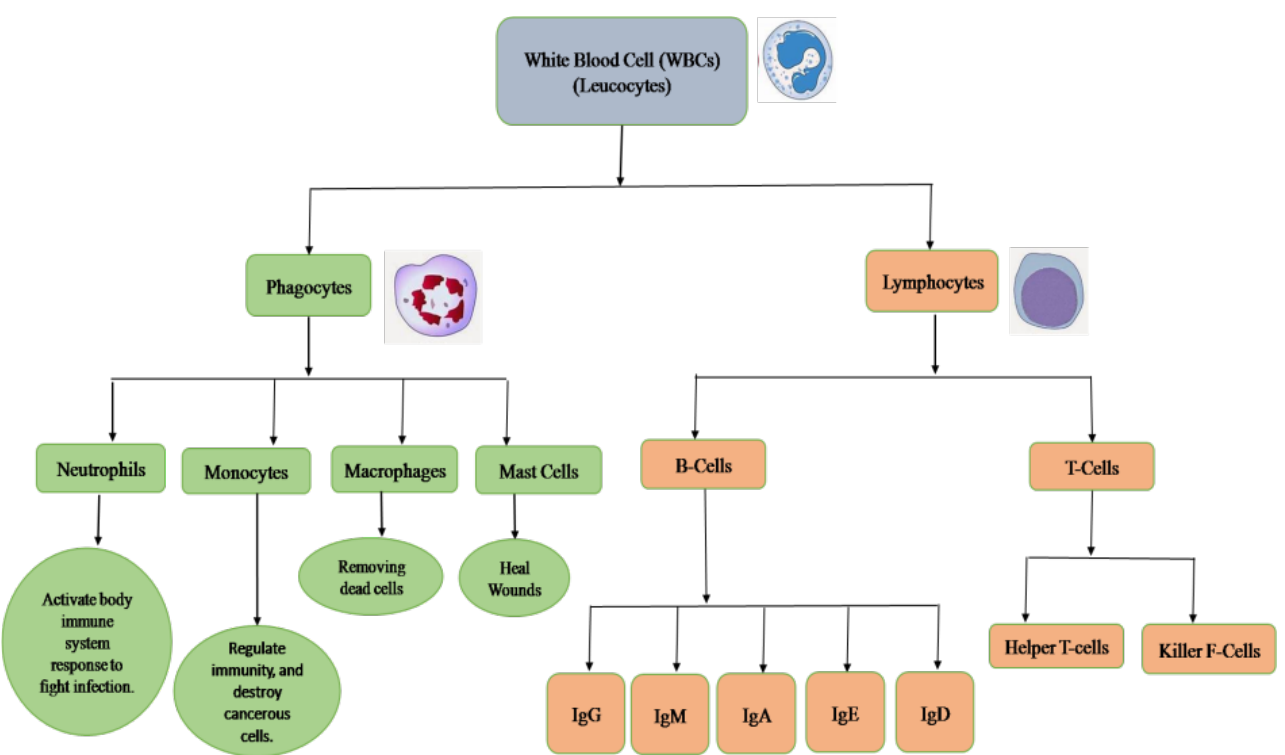
FIGURE 2 - Immune system of human